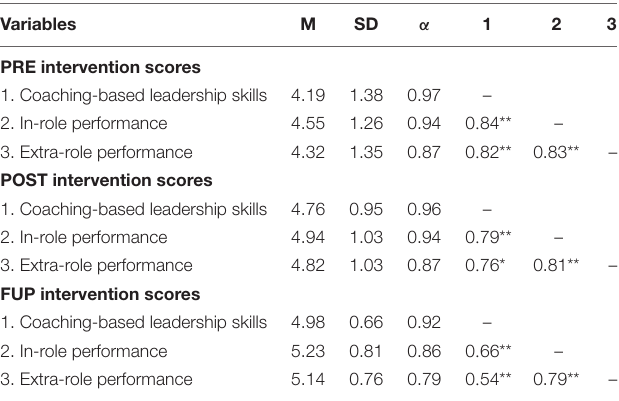
TABLE 4 | PRE, POST, and FUP employee score means, standard deviations, internal consistencies, and correlations of all variables for the whole intervention